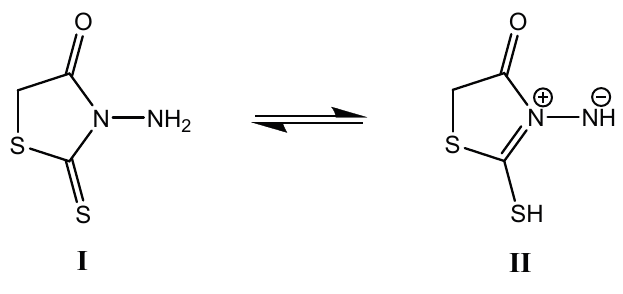
Figure 2. Tautomeric forms of